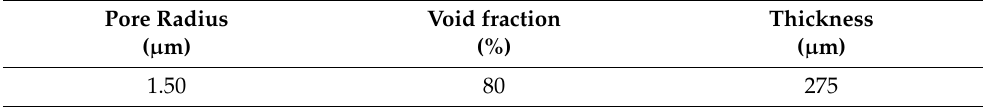
Table 2. Sartobind ® Q membrane specifications [38].